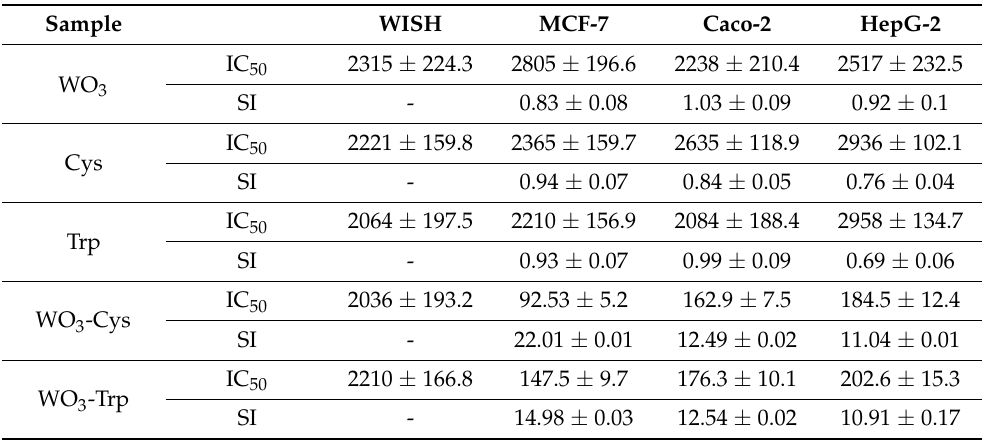
Table 2. EC 100 , IC 50 ( µ g/mL), and SI values of the modified WO 3 -Cys and WO 3 -Trp NPs against WISH, MCF-7, Caco-2, and HepG-2 cell lines after treatment for 48 h in comparison with WO 3 NPs and free amino acids (Cys and